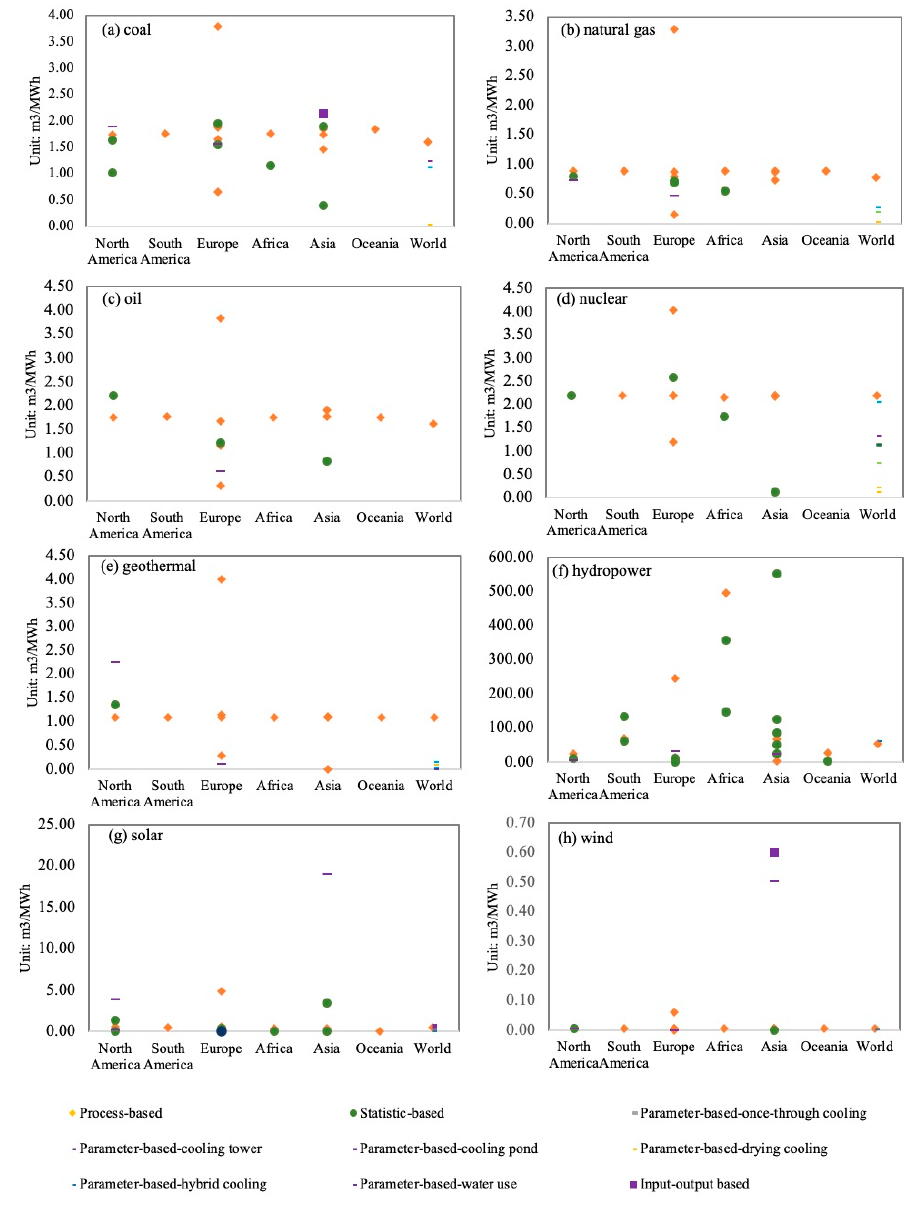
Figure 5. Water footprints of di ff erent power technologies in resolutions of North America, South America, Europe, Africa, Asia, Oceania, and the world. ( a ) coal; ( b ) natural gas; ( c ) oil; ( d ) nuclear; ( e ) geothermal; ( f ) hydropower; ( g ) solar; ( h ) wind. (Note: The orange diamond marker in Figure 5 represents the process-based method at the regional level [34]. The purple process-based marker represents the assessment at the country level. For example, a country in Asia). (In the calculation of the water use of power generation for Combined Heat and Power (CHP) systems, the fuel input provides both heat and power. It is assumed that thermal production contributes 90% of the total water use and heat contributes 10% and that no cooling water is required for district heating systems [34]; the green dot denotes the statistic-based method using a meta-analysis [25]; the short line is the parameter-based method for di ff erent cooling technologies for natural gas-fired power generation [39], renewable power generation [40], and coal-fired power generation [41]; the purple square is the input-output method for calculating the water footprint of coal-fired [42] and wind power [43] in China; the long line represents the process method in Europe [33] and in the USA